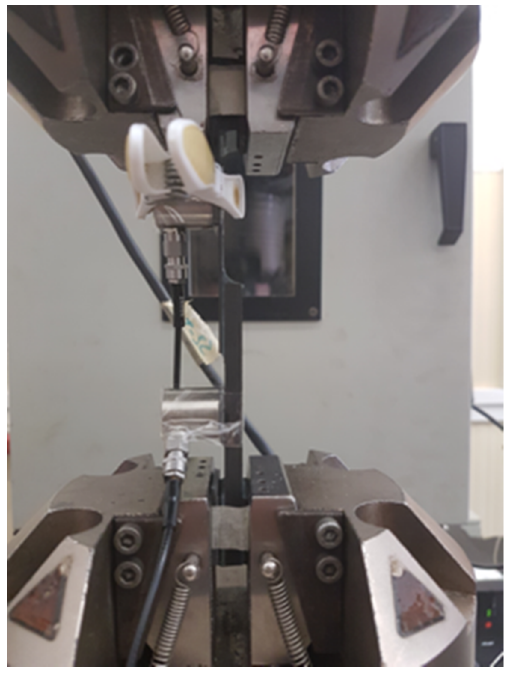
Figure 2. Testing setup with SLS specimen mounted along with the Acoustic Emission (AE) sensors.